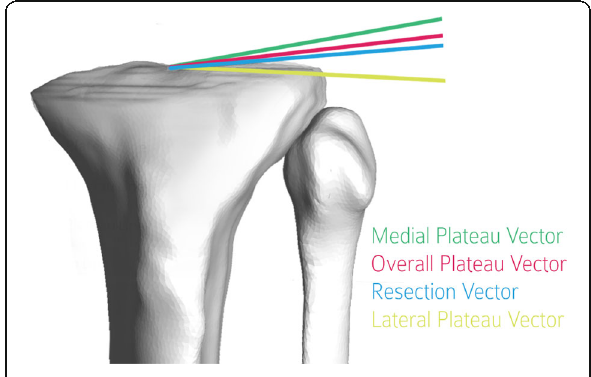
Fig. 2 Relative varus orientation measured after projection on coronal plane (Subject 11). [Directions are shown eminating from a single point to facilitate visualization of